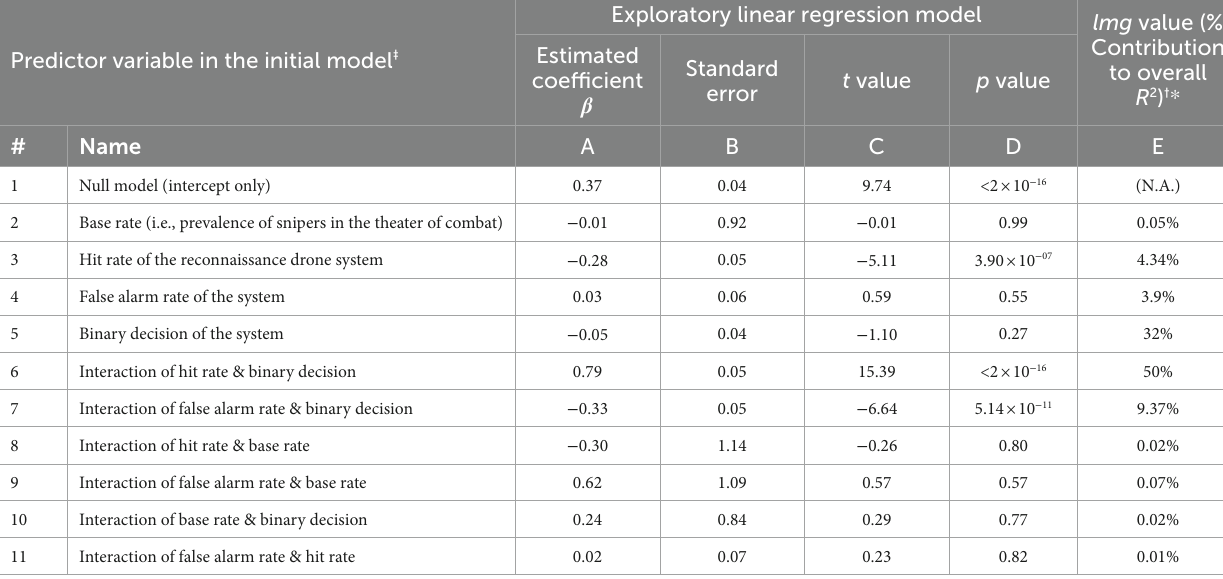
TABLE 4 Summary of regression modeling of the reported probabilities in Experiment 4.